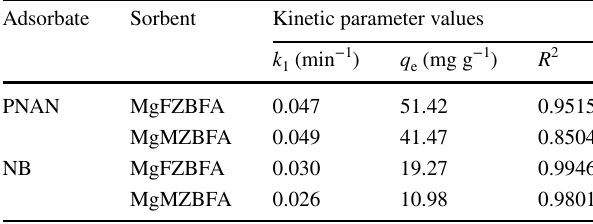
Fig. 17 Pseudo-second-order kinetic model plots for the sorption of a PNAN, b NB on MgFZBFA and MgMZBFA Table 7 Pseudo-first-order kinetic model parameters for the sorption kinetic model (Table 7) and pseudo-second-order kinetic of PNAN and NB on MgFZBFA and MgMZBFA